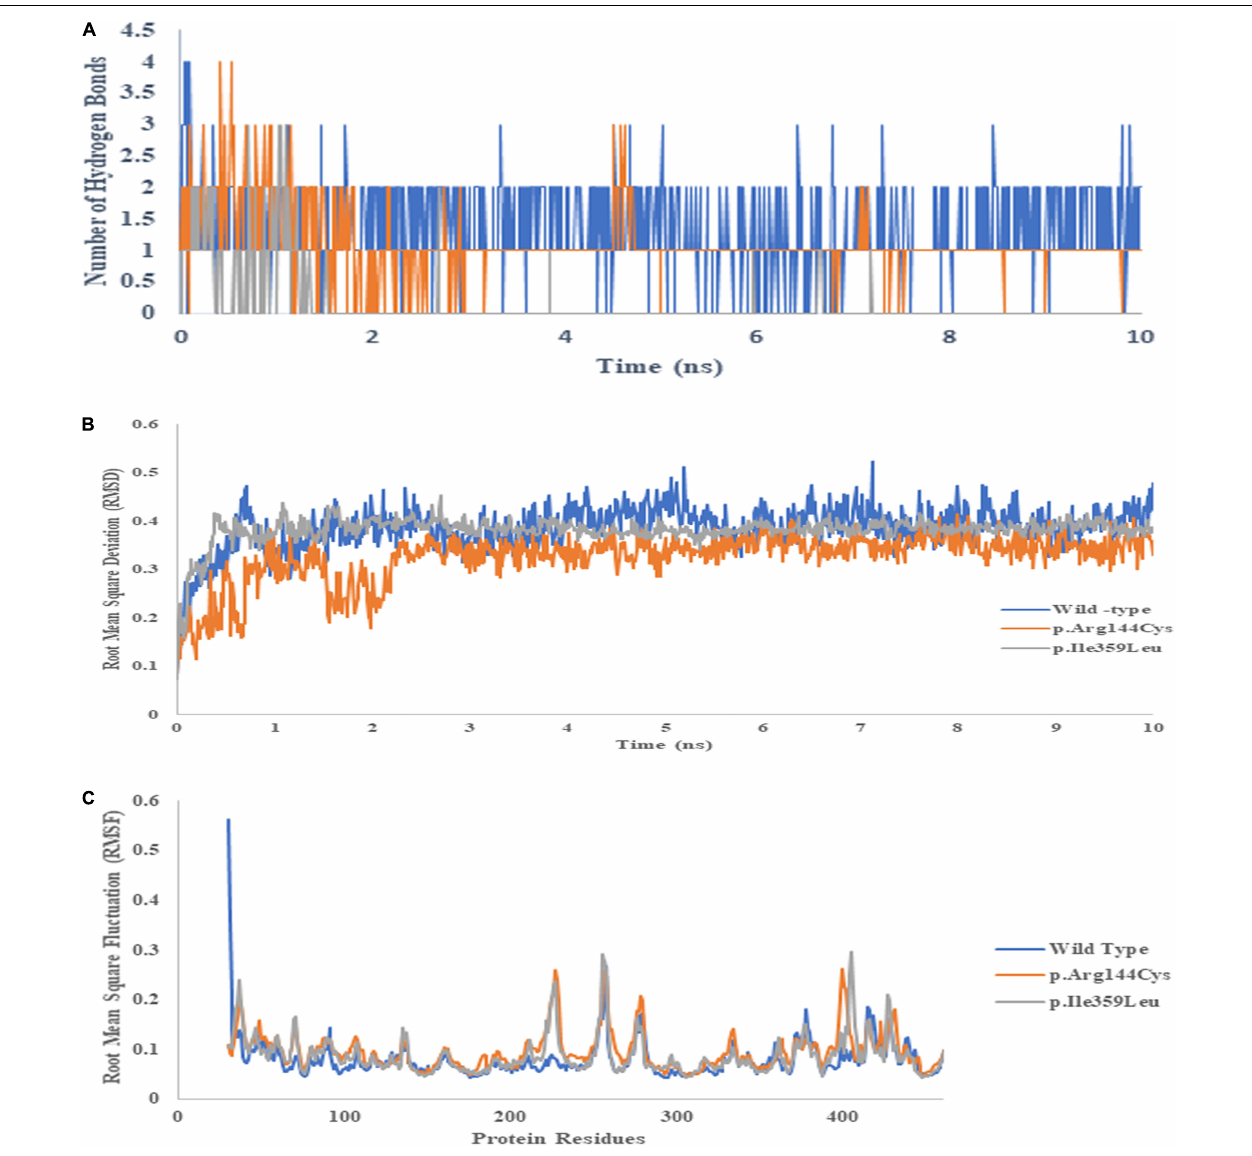
FIGURE 10 | Binding energies of warfarin with the wild type (A) , p.Arg144Cys (B) , and p.Ile359Leu (C) derived from 10 ns MD trajectory analysis. The blue line represents Coul–SR interactions, whereas the orange line depicts LJ–SR